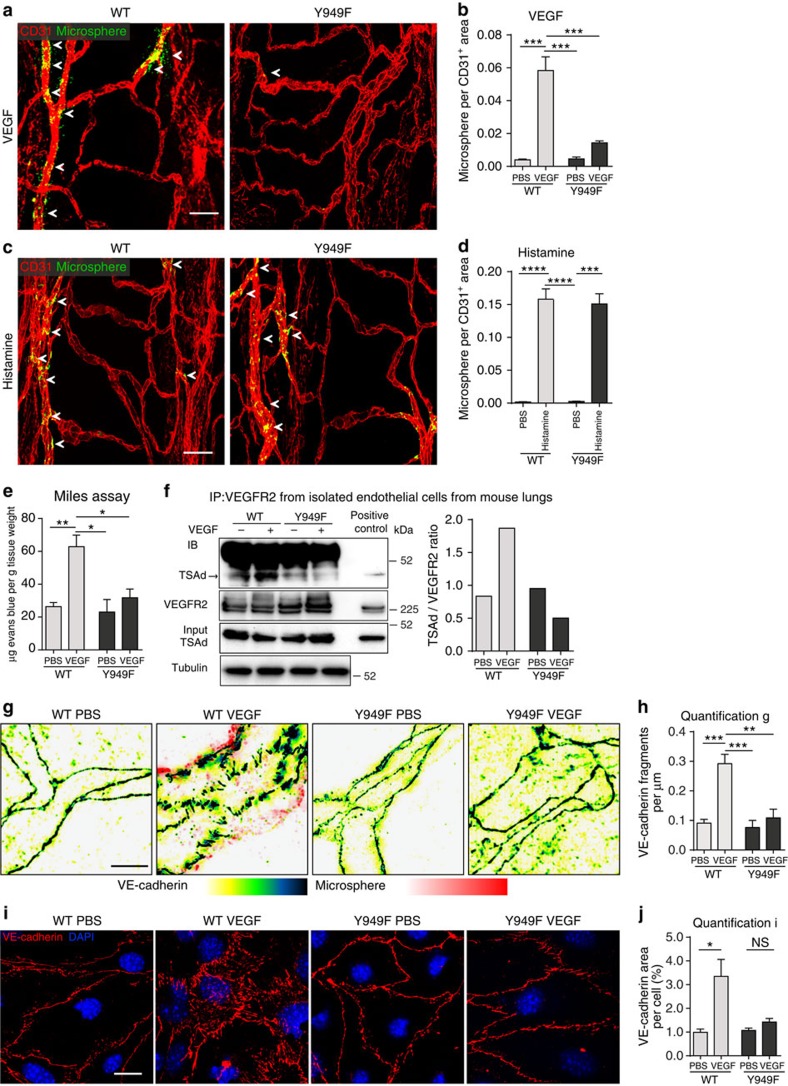
Arrest in VEGFA-induced vascular leakage in Vegfr2Y949F/Y949F mice.(a) Tracheal vessel leakage in WT (left) and Vegfr2Y949F/Y949F (Y949F; right) mice after tail vein injection of VEGFA or PBS combined with 30 nm fluorescent microspheres (green). Arrows: microsphere leakage from CD31+ vessels (red). Scale bar, 50 μm. (b) Microsphere area per CD31-positive area fraction in VEGFA/PBS samples from a. n=3 mice per genotype. Two-way ANOVA: P(treatment)<0.0001; P(genotype)=0.001; P(interaction)=0.0008. (c) Tracheal vessel leakage in response to tail vein-injected histamine (as in a), in WT and Vegfr2Y949F/Y949F (Y949F) mice. (d) Microsphere area per CD31-positive area fraction in histamine/PBS samples from c. n=3–6 mice per genotype. Two-way ANOVA: P(treatment)<0.0001; P(genotype)=0.84; P(interaction)=0.80. (e) Evans' blue extravasation induced by VEGFA/PBS in the dermis of WT and Vegfr2Y949F/Y949F (Y949F) mice. Values were normalized to tissue weight. n=3 mice per genotype. Two-way ANOVA: P(treatment)=0.0053; P(genotype)=0.0206; P(interaction)=0.0482. (f) VEGFR2/TSAd complex formation in isolated mouse lung endothelial cells from WT and Vegfr2Y949F/Y949F (Y949F) mice, treated or not with VEGFA. Immunoprecipitation (IP) for VEGFR2 and immunoblotting for TSAd and VEGFR2. Total lysates were immunoblotted for TSAd and tubulin. Positive control, total lysate. Molecular weight markers to the right. (g) VE-cadherin immunostaining (yellow–black heatmap) on trachea from WT and Vegfr2Y949F/Y949F (Y949F) mice, tail vein-injected with VEGFA/PBS and microspheres (pink–red heatmap). Images were rendered using structured illumination microscopy. Note VE-cadherin rearrangement in VEGFA-injected WT trachea. Scale bar, 10 μm. (h) VE-cadherin fragments per μm vessel length from g. n=3–6 individual tissues per genotype. Total vessel length assessed: WT/PBS, 236 μm; WT/VEGFA, 308 μm; Y949F/PBS, 150 μm; and Y949F/VEGFA, 145 μm. Two-way ANOVA: P(treatment)=0.0022; P(genotype)=0.0065; P(interaction)=0.0164. (i) VE-cadherin immunostaining (red) on endothelial cells isolated from WT and Vegfr2Y949F/Y949F (Y949F) mouse lungs and then treated or not with VEGFA (100 ng ml−1). Hoechst 33342 (blue) staining shows nuclei. Scale bar, 20 μm. (j) VE-cadherin-positive staining per cell; samples generated as in i. n=30 cells per condition. Two-way ANOVA: P(treatment)=0.0189; P(genotype)=0.099; P(interaction)=0.0741. Data presented as mean±s.e.m. Two-way ANOVA with Tukey's post hoc test, *P<0.05, **P<0.01, ***P<0.001, ****P<0.0001. Experiments were performed at least three independent times.